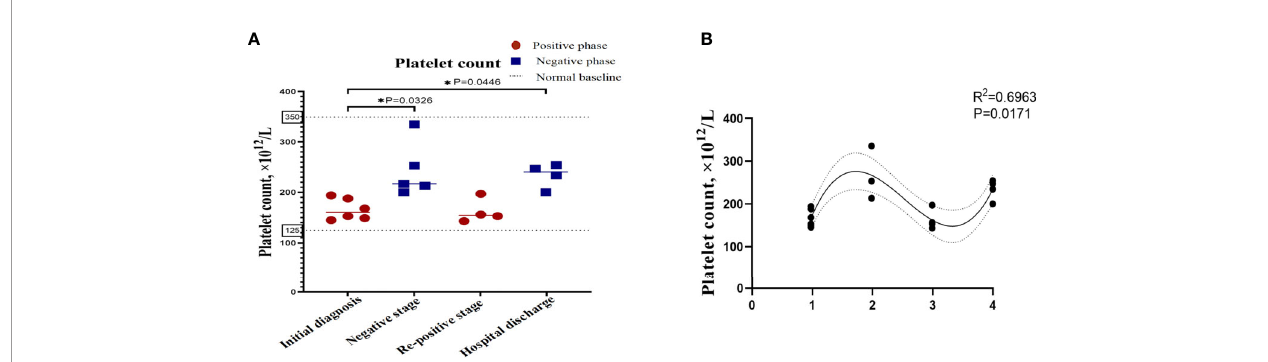
FIGURE 3 | Platelet counts in re-positive patients of COVID-19 at different phases. The platelet count of the patients with re-positive was lower than that of the negative stage in the initial stage and the re-positive stage, and the difference was statistically signi fi cant. (A) Platelet count at different stages of the patients. The X-axis represents the stage of the patient's course, which is segmented based on RT-PCR results, and the Y-axis is the value of the index. The red dots represent the positive results of RT-PCR and the blue dots represent the negative results of RT-PCR. The values are the mean values. Data that is not shown is not available. (B) Correlation between platelet count and RT-PCR results. R2 represents the degree of fi t between the data points and the curve. The number on X-axis represents four rounds of RT-PCR.